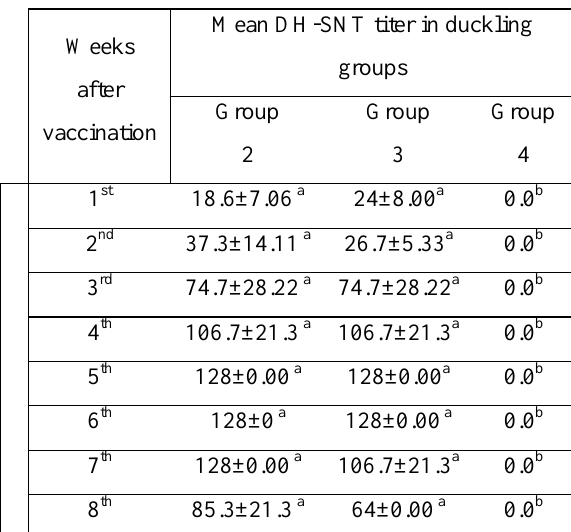
Table 2: Mean DVH-SNT antibodies in vaccinated duckling groups